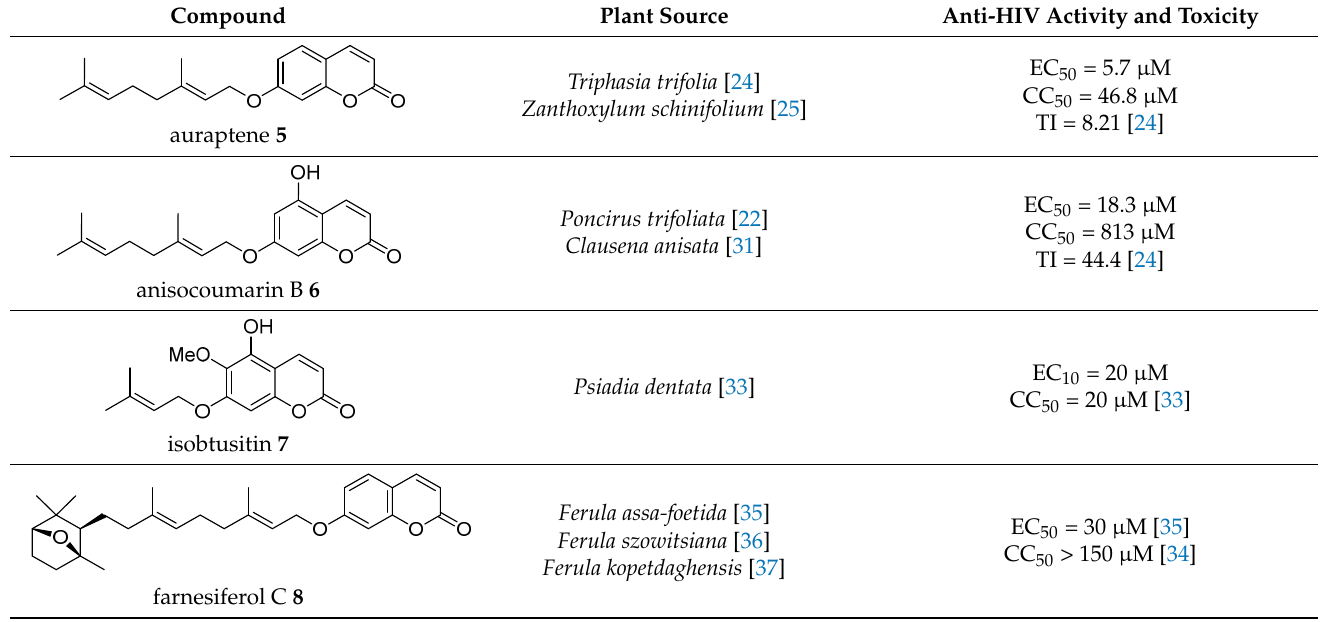
Figure 3. Anti-HIV hydroxy- and methoxycoumarins 1 – 3 . Citropten (5,7-dimethoxycoumarin) 2 and 6,8-dimethoxycoumarin 3 (Figure 3), found in the plant families Campanulaceae [20] and Rutaceae [21,22], showed moderate anti-HIV activity with EC 50 = 33.8 µ M and CC 50 = 417 µ M (TI = 12.4) and EC 50 = 100.9 µ M and CC 50 > 970.9 µ M (TI > 7.36), respectively [22], while 5,7,8-trimethoxycoumarin 4 (Figure 3) from Zapota ailanthoides showed high activity with EC 50 = 0.933 µ M and TI = 107 [23]. Various derivatives of terpene coumarins and related compounds isolated from plants of the families Rutaceae [22–28], Umbelliferae [29,30], Fabaceae [31,32] were found to be active against HIV (Table 1) [22–24,32]. Among them, auraptene 5 and anisocoumarin B 6 inhibit the replication of HIV-1 (strain LAV-1) with EC 50 activities of 5.7 µ M and 23.2 µ M, respectively, on peripheral blood mononuclear cells [24]. Regarding the HIV-1 IIIB strain, the activity of auraptene 5 was 10 times lower (EC 50 = 59.7 µ M) in the C8166 cell line [24]. Anisocoumarin B 6 inhibits HIV viral replication with EC 50 18.3 µ M, with a sufficiently high TI > 44.4 [22]. In Sup T1 cells, Isobtusitin 7 had a weak HIV inhibitory effect (about 10%) with a concentration close to CC 50 , namely 20 µ g/mL [33]. Farnesiferol C 8 (Table 1) is a well-known sesquiterpene coumarin isolated from genus Ferula ( Apiaceae ) species such as Ferula assafoetida and Ferula szowitsiana . It has been reported to have cytotoxic, apoptotic, MDR reversal, antitumor, antimutagenic, and antiviral activity [34]. Recently, farnesiferol C 8 was identified as an HIV-1 RT inhibitor with a mixed inhibition mechanism (IC 50 = 30 µ M). Using theoretical and experimental methods, it was demonstrated that farnesiferol C 8 could quench the intrinsic fluorescence emission of HIV-1 RT through a static quenching mechanism, while molecular docking studies indicated that farnesiferol C 8 interacts with the enzyme through a hydrophobic pocket [35]. Table 1. O-terpenoid anti-HIV coumarins.